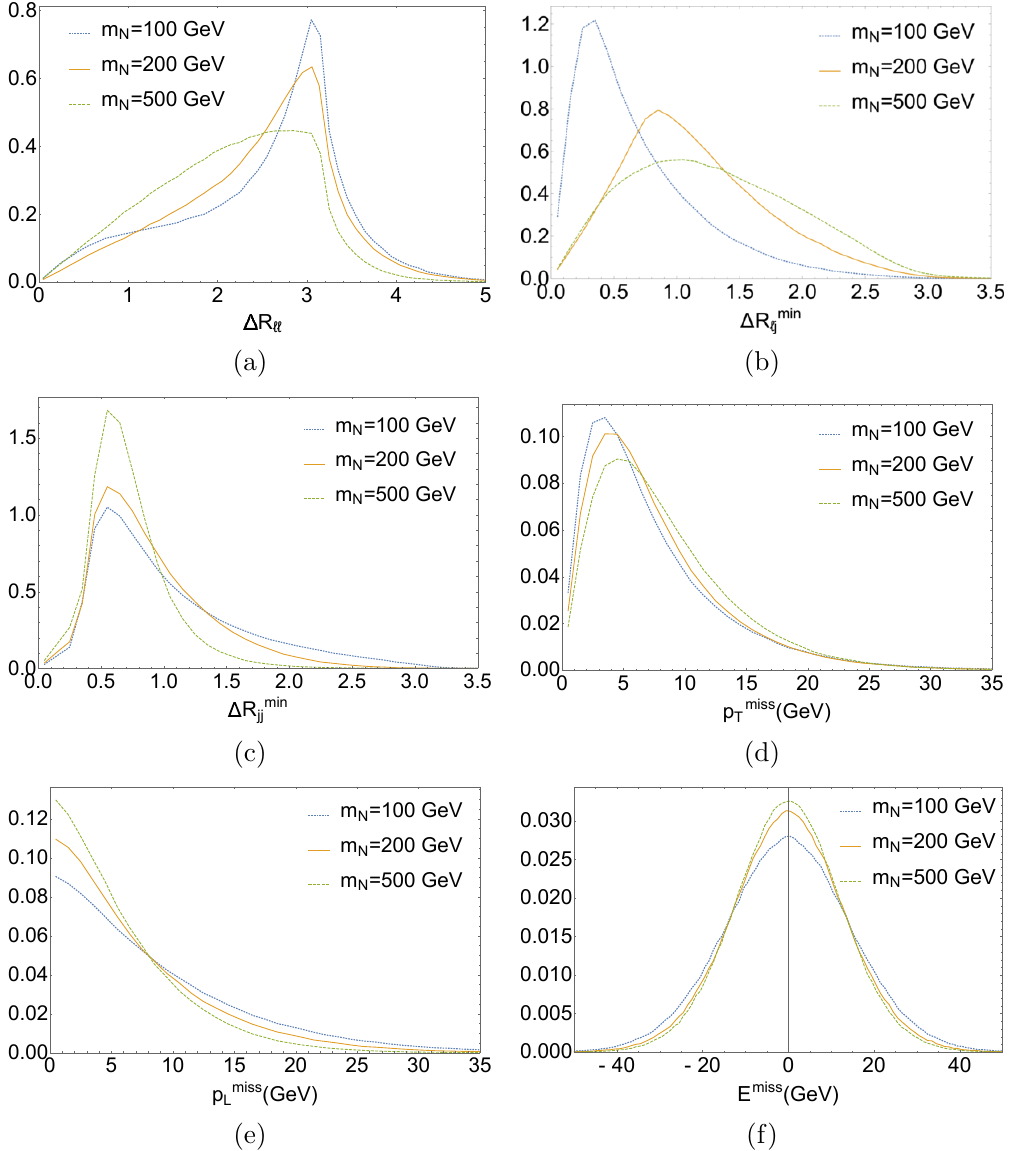
Figure 8 . Normalized distributions (cid:27) (cid:0) 1 d (cid:27)= d X for m N = 100, 200 and 500 GeV at the 1 TeV ILC for (a) the radial isolation of muon pairs (cid:1) R ‘‘ ; the minimal radial isolation (b) (cid:1) R min (cid:1) R min ; (d) the missing transverse momentum =p jj (f) the missing total energy =E . The missing total energy is the c.m. energy 1000 GeV minus the sum of energies of all visible particles in the (cid:12)nal state.